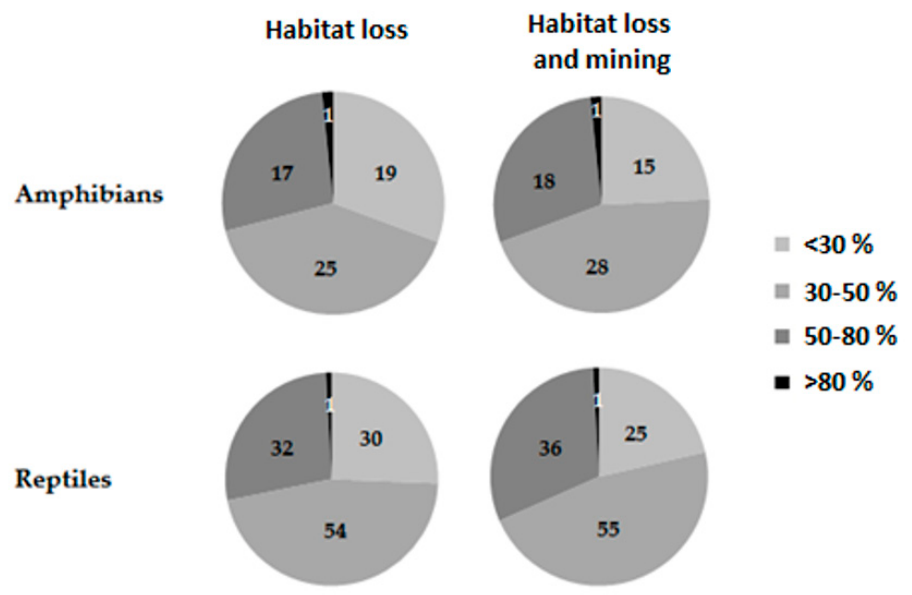
Figure 1. Number of Mexican endemic species of amphibians and reptiles in each group of percentage of distribution lost under each scenario.